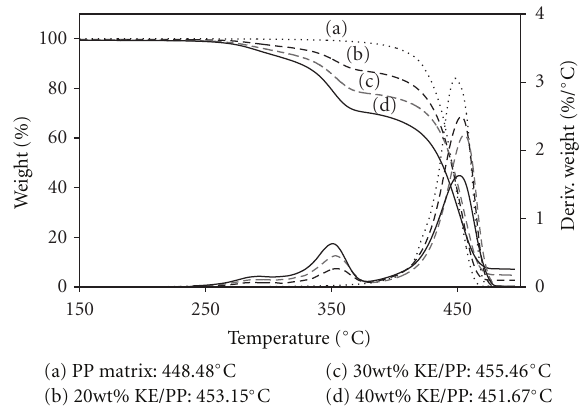
Figure 7: Thermogravimetric analysis of PP and PP composites.